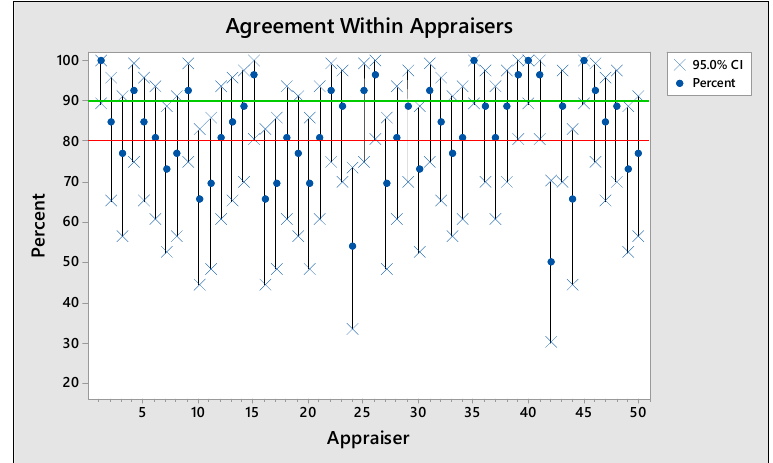
Figure 3. Agreement within appraiser graph. There are two agreement thresholds, namely acceptable agreement and excellent agreement indicated by the red and green line respectively. Data for static images only, without the usual ability to view the blade from different perspectives and tactile feeling of the blade.